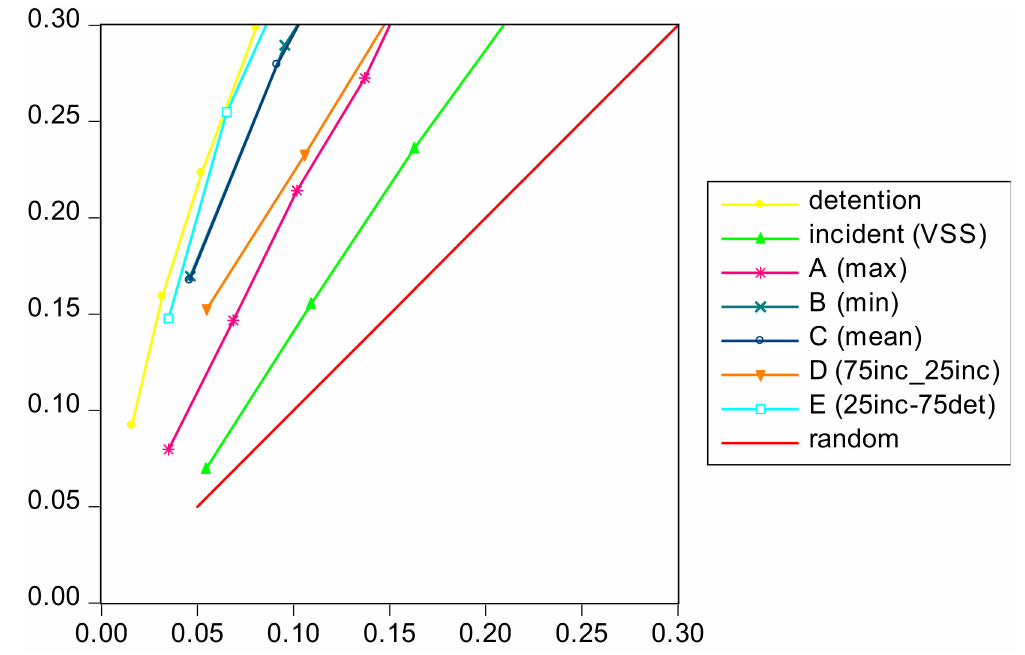
Figure 2. ROC curve top 30%—evaluation variable detention: total detentions 1868.